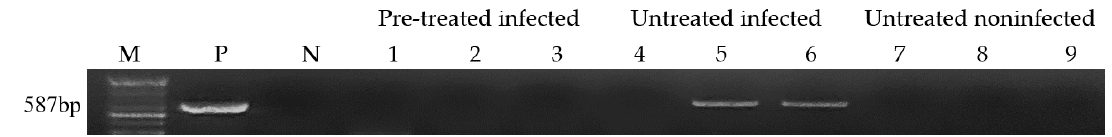
Figure 6. PCR analysis of the EPC cells inoculated with intestine, kidney, or spleen tissue homogenates from olive flounder ( Paralichthys olivaceus ). Lanes 1, 4, and 7= intestine; lanes 2, 5, and 8 = kidney; lanes 3, 6, and 9 = spleen; N = negative control (deionized sterile water); P = positive control (VHSV); M: 100 bp DNA ladder.